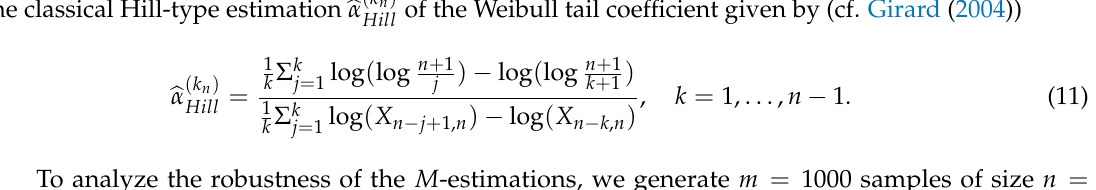
( v , ∞ ) ∗ ( v , ∞ ) n ( left ) and T n ( right ). Here G ( x ; α ) is given by (1) with c 0 W